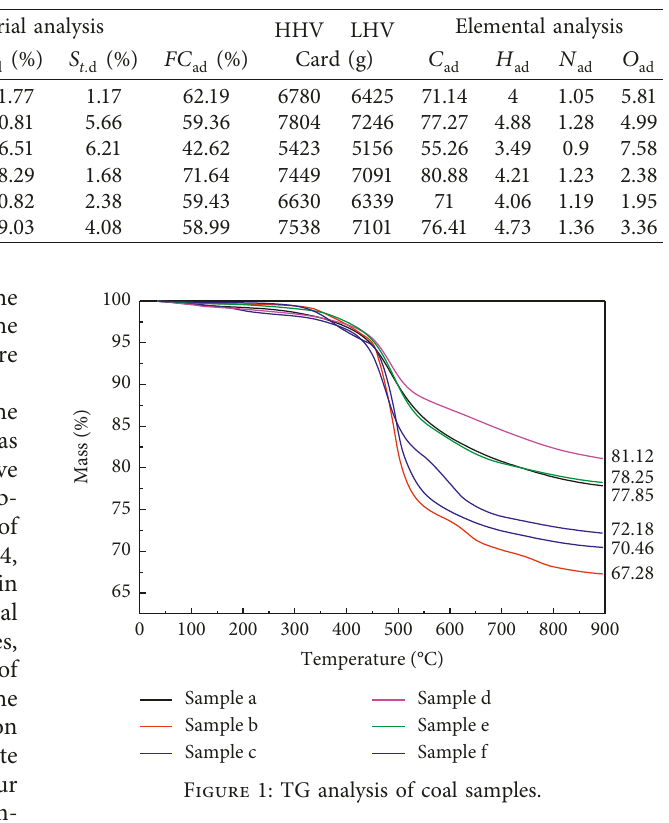
Table 1: Proximate analysis of the investigated samples.